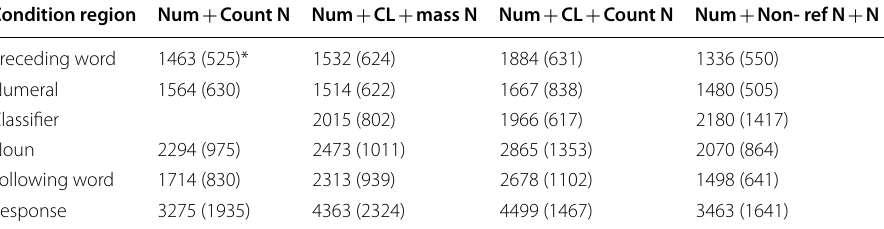
*Standard deviations are added in